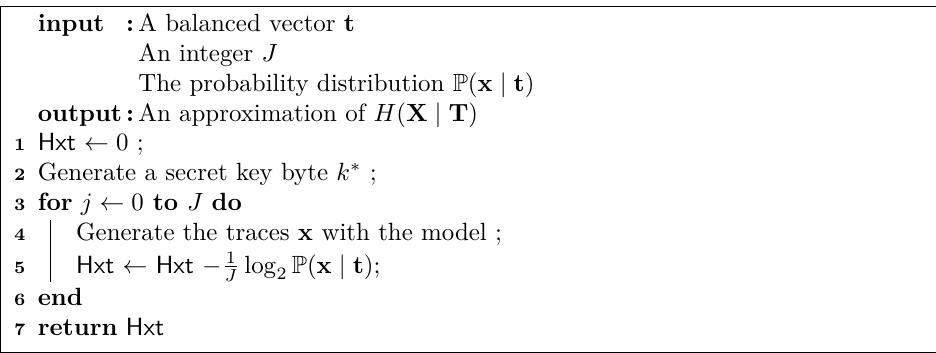
Algorithm 1: Computation of the entropy using the law of large